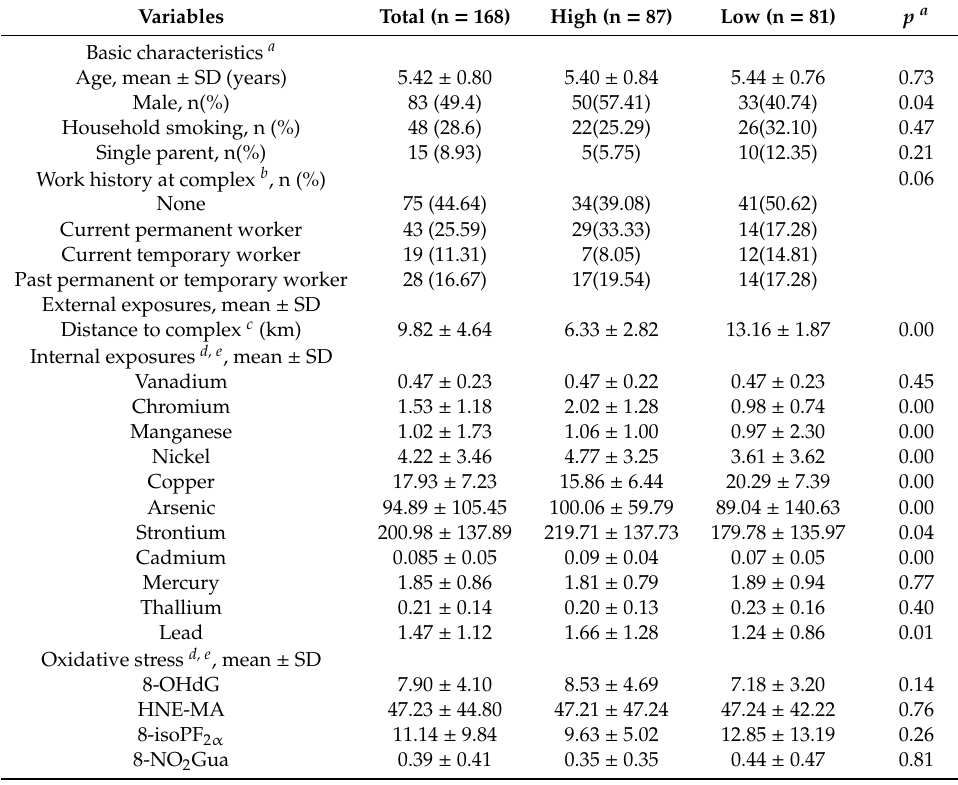
Table 1. Comparison of basic characteristics, urinary heavy metal exposure levels, and urinary oxidative stress biomarker levels between high and low exposure